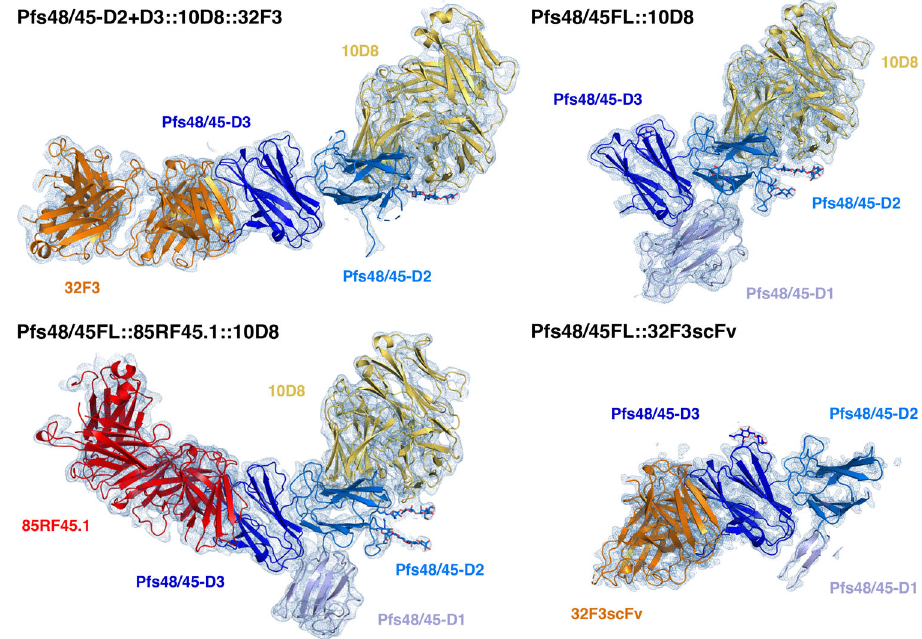
Fig. 2 | Structures of Pfs48/45 bound to antibodies 85RF45.1, 32F3 and 10D8. Structures ofPfs48/45boundto different combinations ofFab fragments or scFvs. Pfs48/45 is shown with the three domains in different shades of blue. The N-terminal domain is light blue, the central domain is mid-blue and the C-terminal